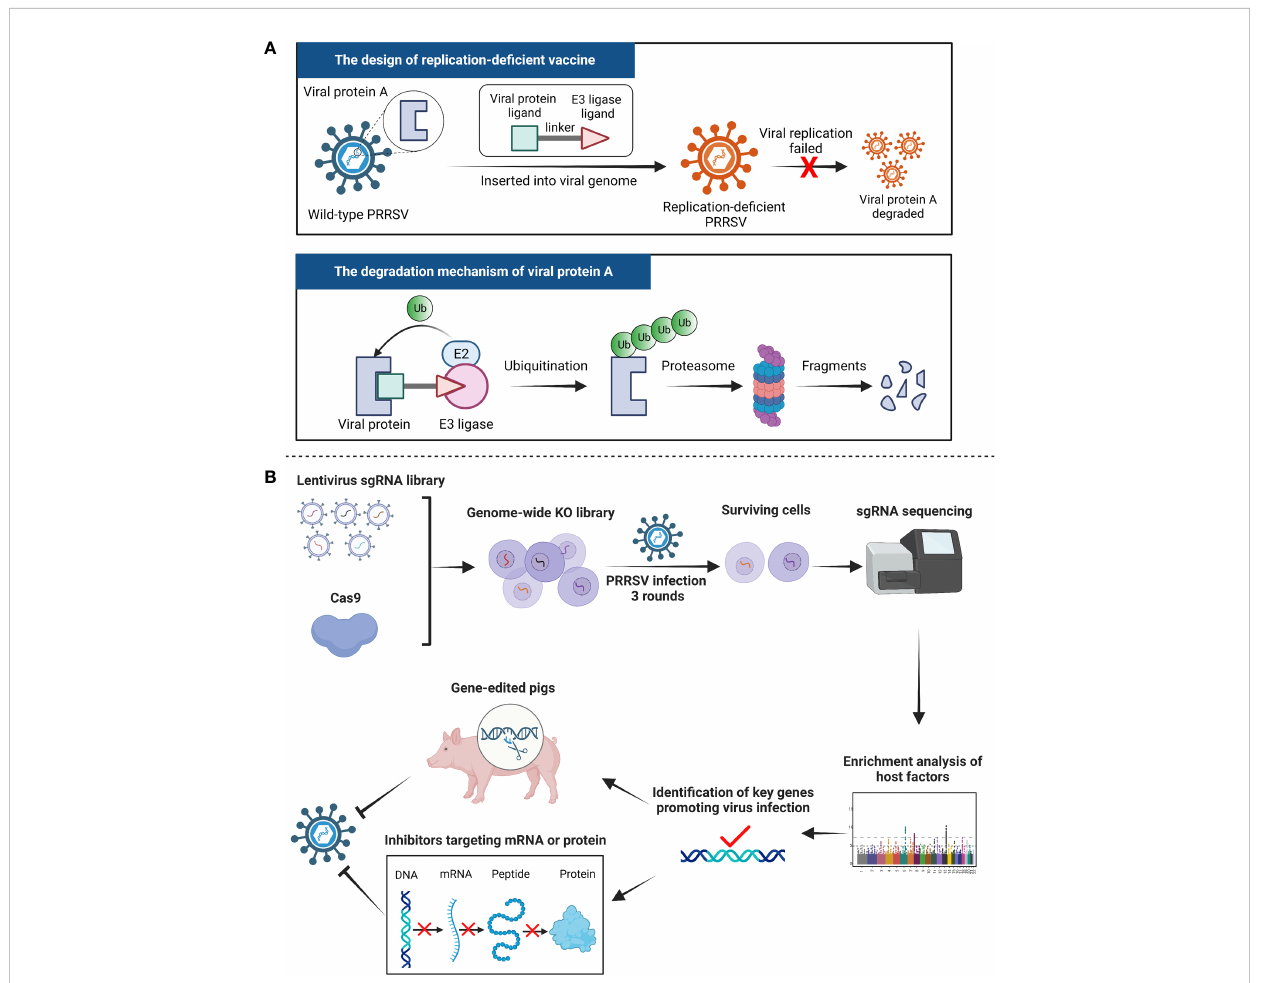
FIGURE 1 Ideas and strategies for PRRSV prevention and control in future. (A) PROteolysis-TArgeting Chimeras (PROTACs), consisting of three structures: a ligand for binding with the protein of interest (POI), a ligand for recruiting an E3 ligase and a linker, have been developed to exploit and hijack host cellular ubiquitin-proteasome system (UPS) to speci fi cally mediate the highly selective degradation of POIs. We can use this technique to develop a novel PRRSV replication-de fi cient vaccine candidate. A certain protein of the virus (namely protein A) is speci fi cally degraded by the host UPS thus the production of progeny viruses fails, suggesting that the vaccine candidate is indeed safer than current modi fi ed live vaccines. (B) A genome-wide CRISPR/Cas9 screening has great potential for the study of PRRSV-host interactions and the identi fi cation of the key regulators mediating virus entry and infection. The key host genes could be used as targets for the development of antivirals and the breeding of disease-resistant